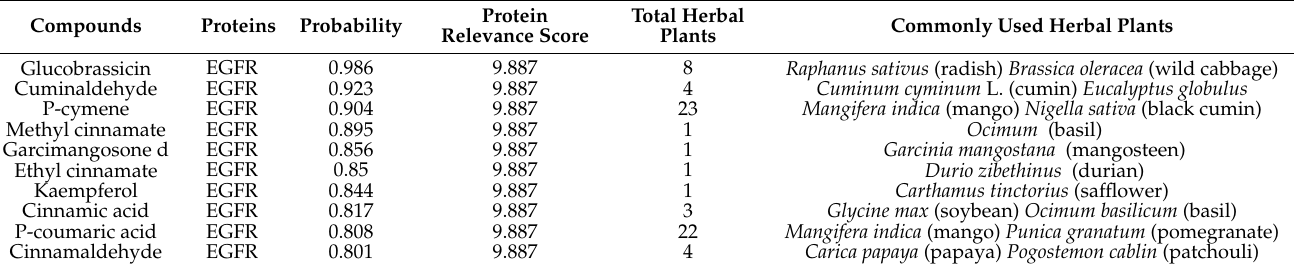
Table 6. Ten compound–protein interactions with the highest protein relevance score of SAE-DNN prediction results with PubChem fingerprint dataset.